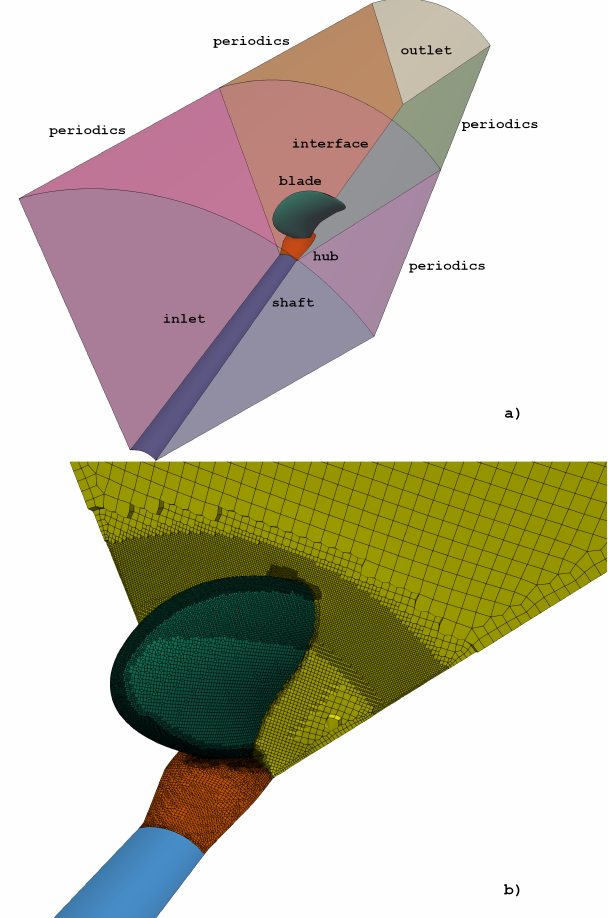
Figure 1. Details of the numerical setup. ( a ) Computational domain with relevant patches and ( b ) cross-sectional detail of a coarse